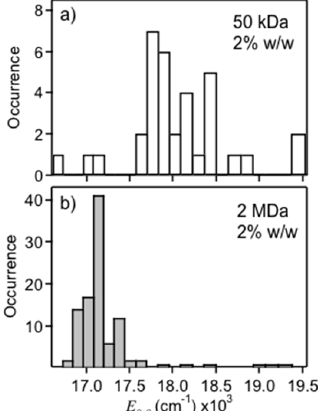
Figure 2. Histograms of the PL E 0-0 maxima for MEH-PPV single molecules dispersed in: 50 kDa ( a ); and 2 MDa ( b ) polystyrene.